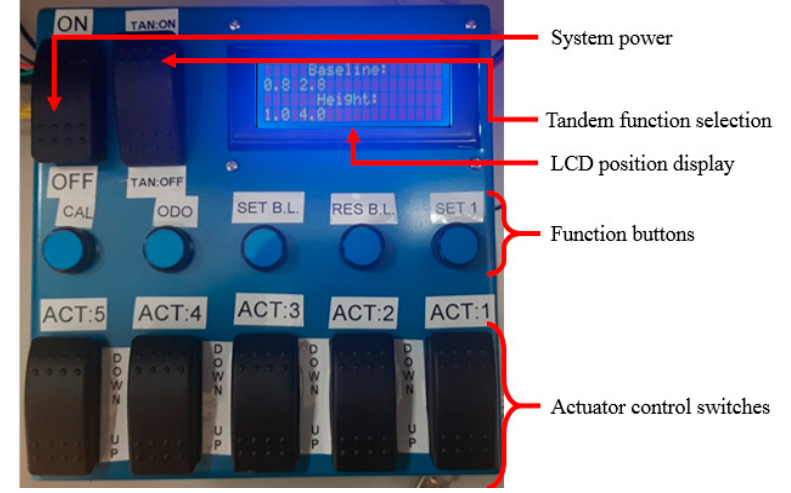
Figure 3. Front of control system showing each of the control functions and display.